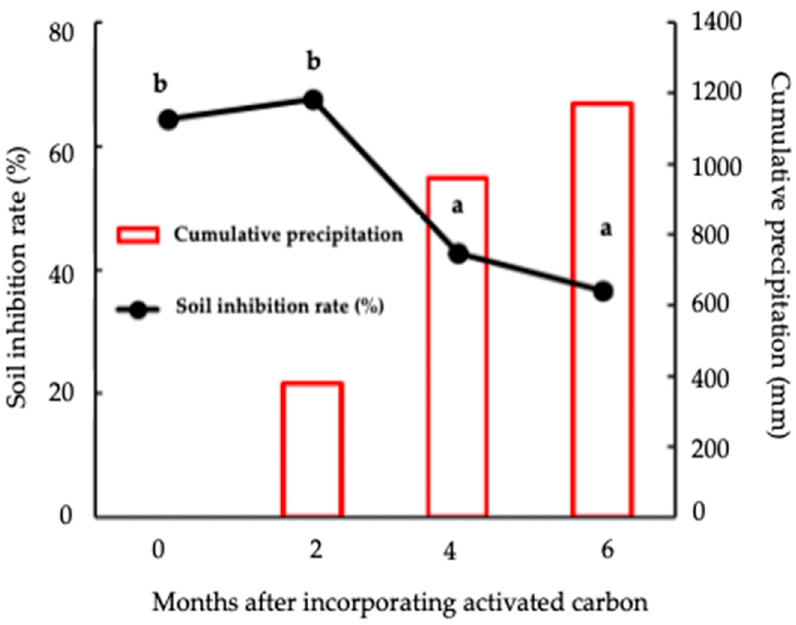
Figure 1. Changes in soil inhibition rate in the pear soil left in the open field and cumulative precipitation. Data were analyzed by Tukey–Kramer method after arcsine transformation. Different letters indicate a significant difference at the 5% level.